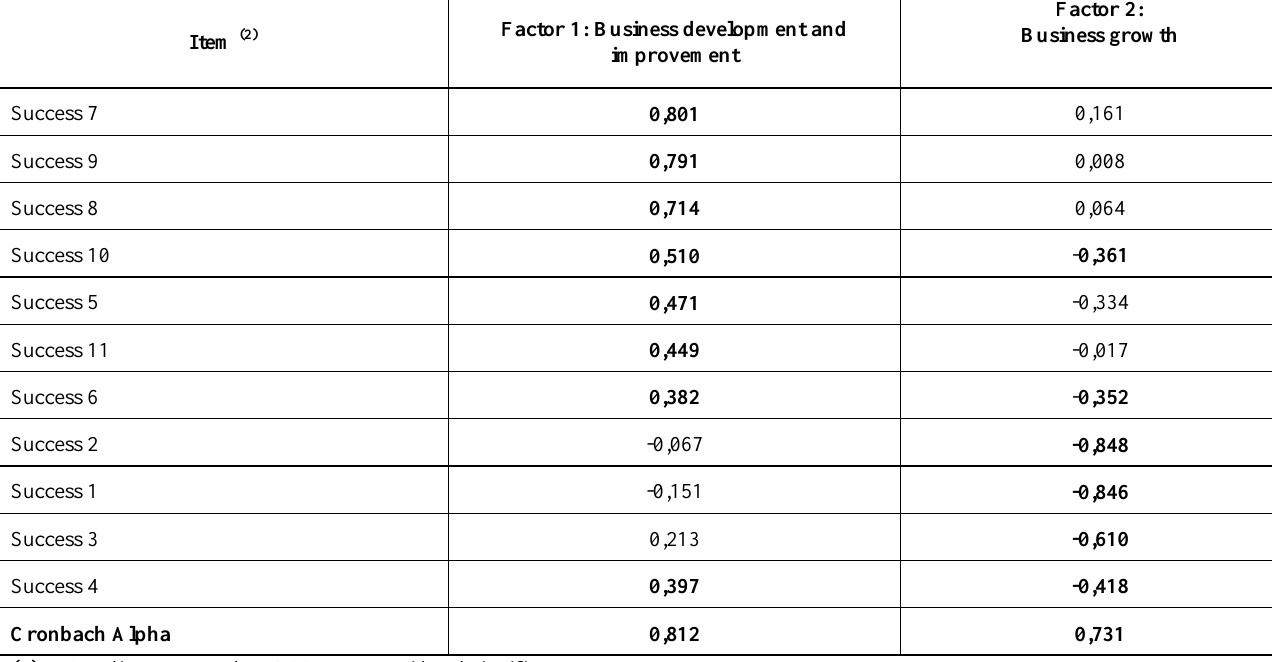
Factor 1: Business development